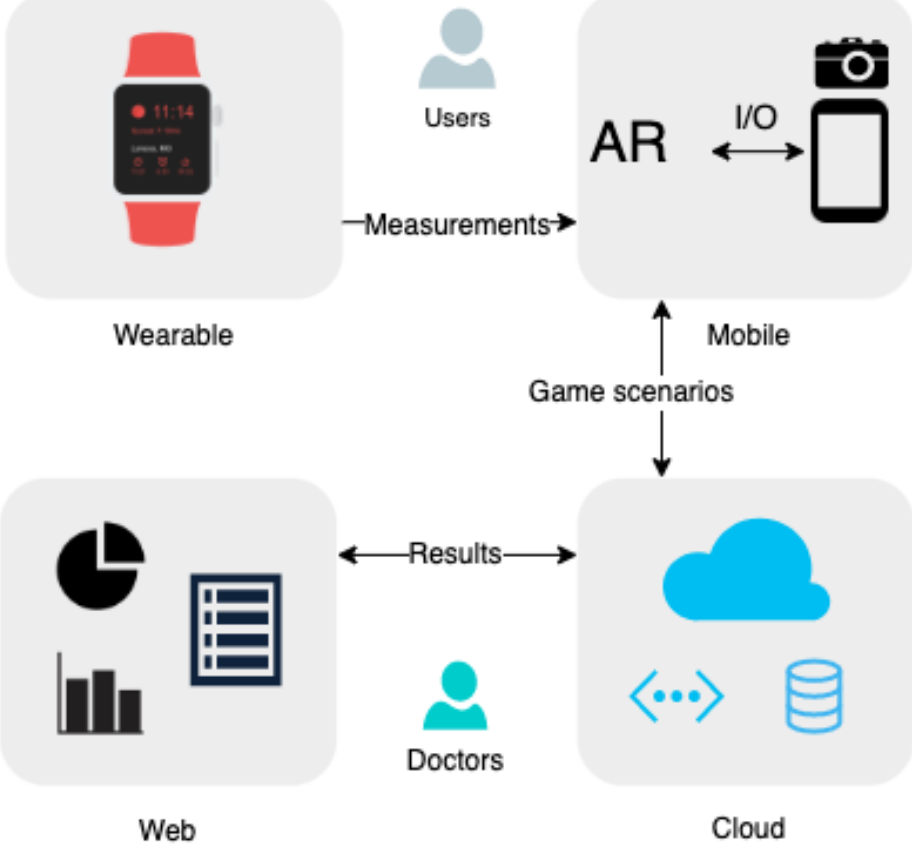
Figure 1. The system overview and the core